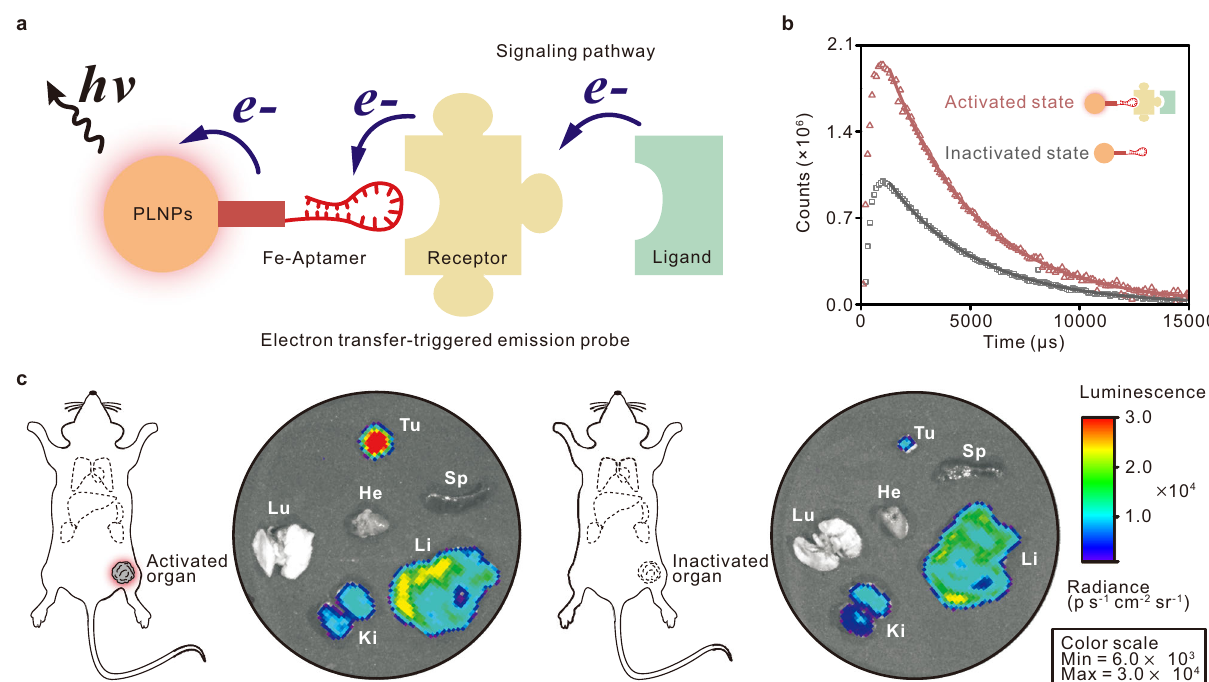
Fig. 1 Schematics of electron transfer-triggered imaging. a Schematic of ETTE nanoprobe for electron transfer-triggered imaging (not to scale). b Time- resolved fl uorescence curve of ETTE nanoprobes in water and in solution with glucose oxidase and glucose. The experiments were repeated independently three times. c Afterglow images of organs and tumors at 48 h after intravenous administration of ETTE nanoprobes without and with MutT homolog 1 (MTH1) siRNA as a therapeutic reagent, respectively. Tu tumor, Sp spleen, Li liver, Ki kidney, Lu lung, He heart. Color scale: 6.0 × 10 3 – 3.0 × 10 4